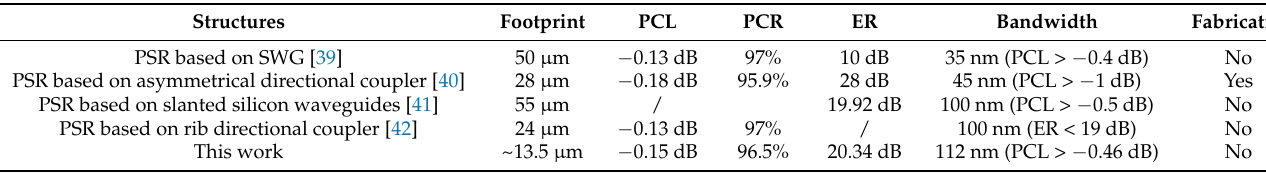
Table 1. Comparison of the reported PSR.